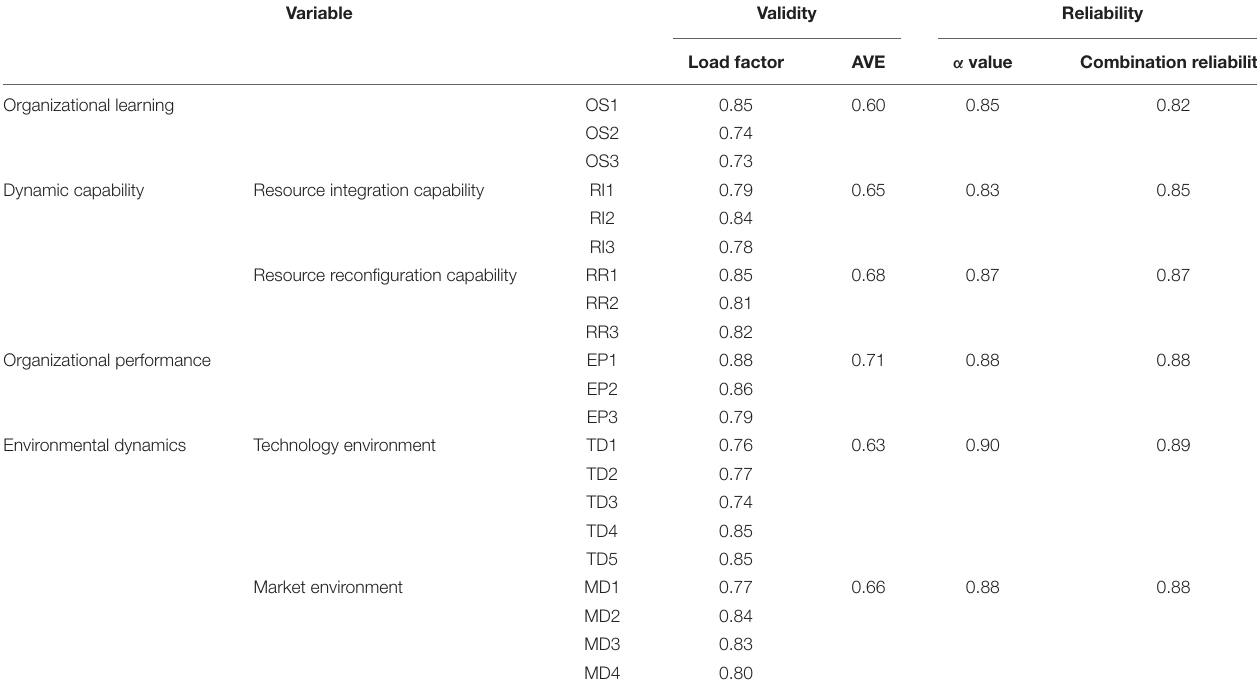
TABLE 3 | Reliability and validity analysis of variables.